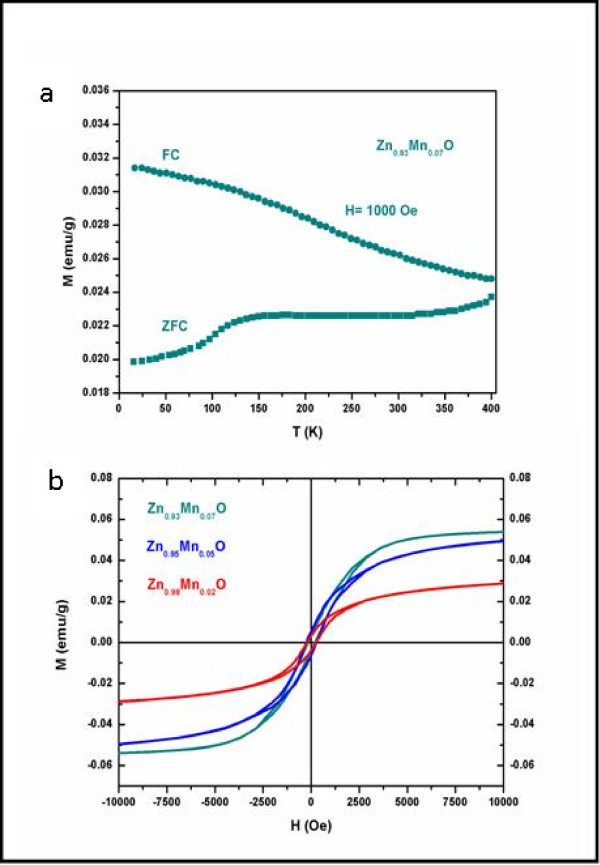
Magnetization. The magnetization as a function of temperature for (a) FC and ZFC (Zn0.93Mn0.07O HMSs); RT M-H (b) of Zn1-xMnxO HMSs (x = 0.02, 0.05, and 0.07).